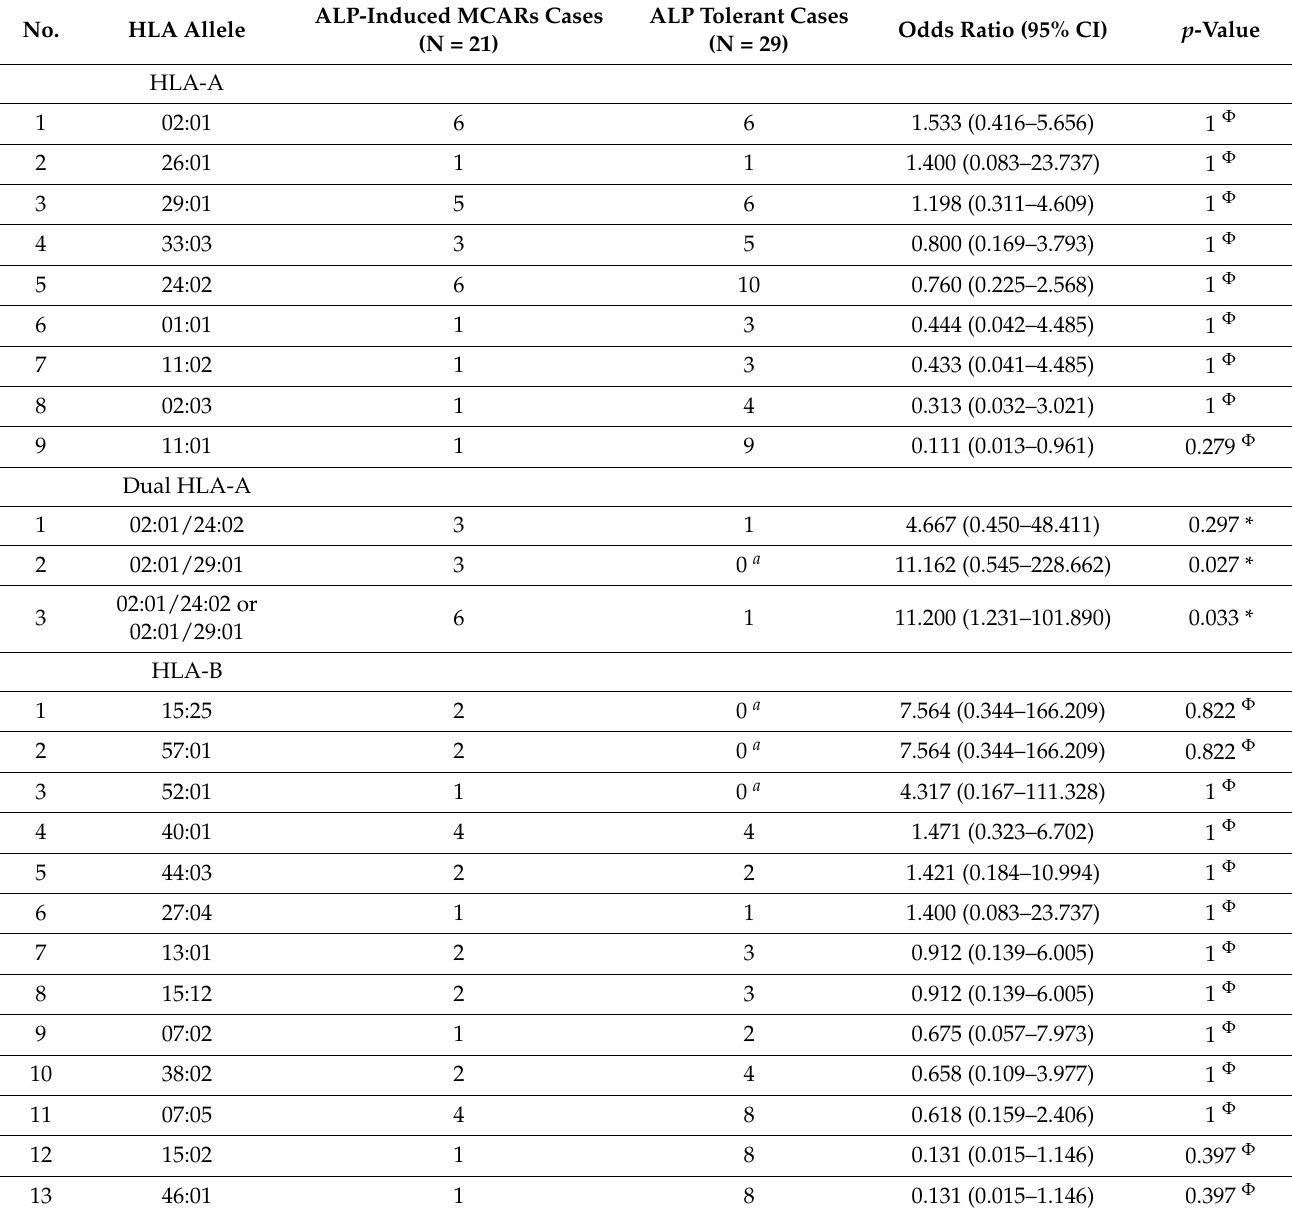
Table 5. Allele frequencies in ALP-induced MCARs patients and ALP-tolerant patients with HLA-B * 58:01 negative.